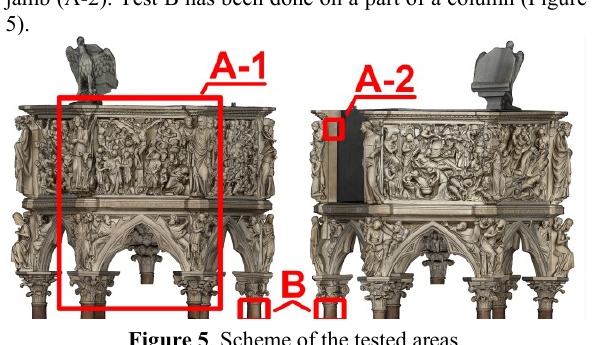
Figure 5 . Scheme of the tested areas.